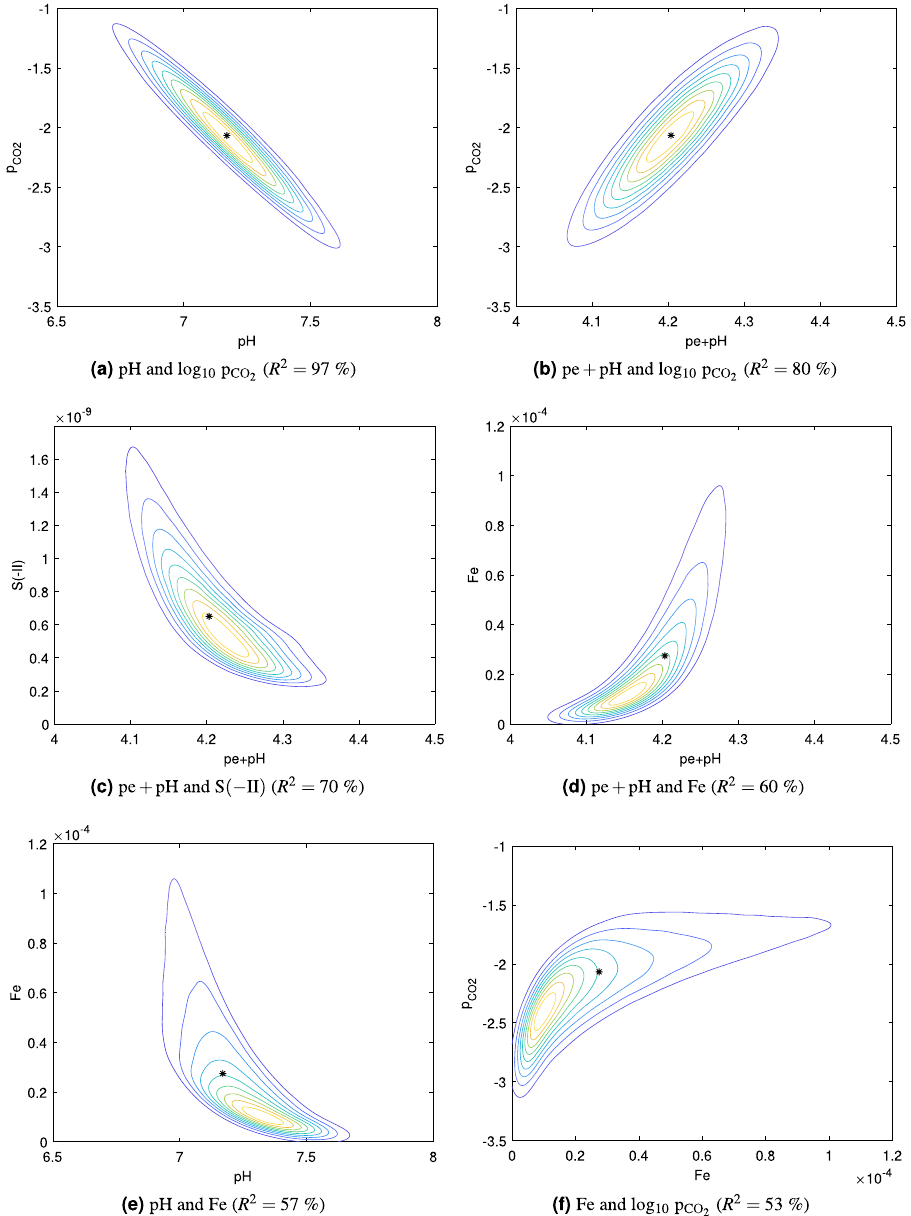
Figure 4. Isolines of bivariate distributions and medians (asterisks) estimated with 10 6 realizations of the surrogate models and the kernel density estimation method for the most correlated pairs of QoI (small range case). The plots are ordered according to the value of R 2